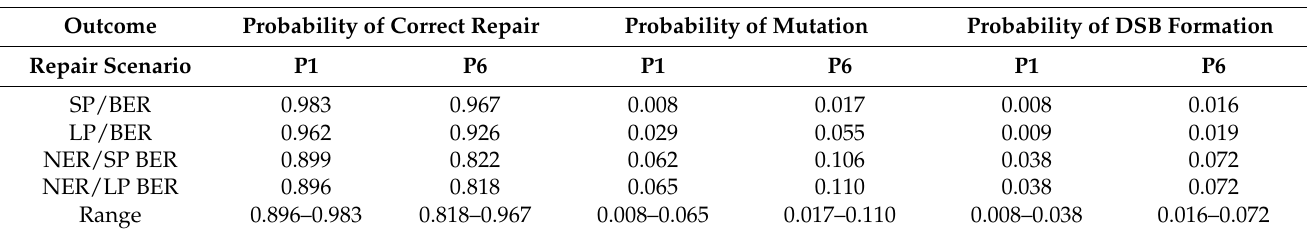
Table 6. The average repair outcome probability for all types of DNA damage for cells irradiated by a 62 MeV proton beam for SP BER, LP BER, SP BER/NER, and LP BER/NER pathways. Average Repair Outcome Probability for all Types of DNA